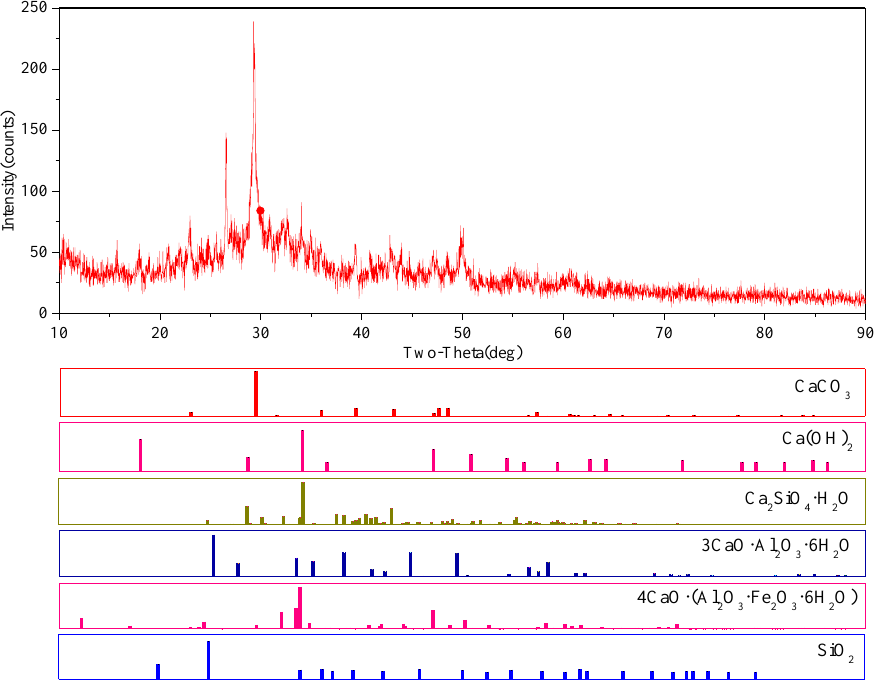
Figure 4. Diffraction pattern and main phases of paste backfill specimen submerged in distilled water for 40 days.